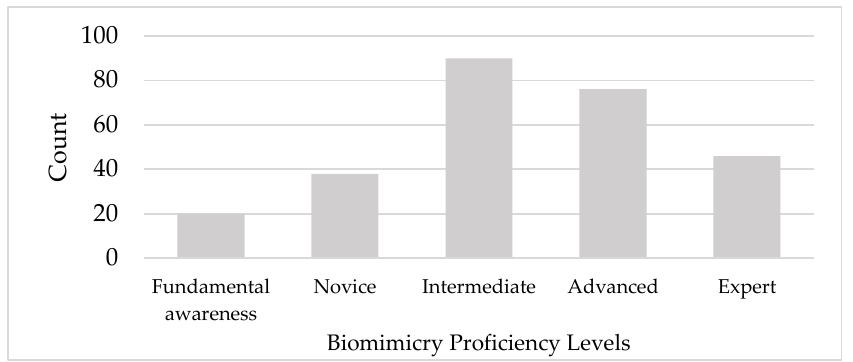
Figure 5. Biomimicry proficiency levels of online survey respondents.